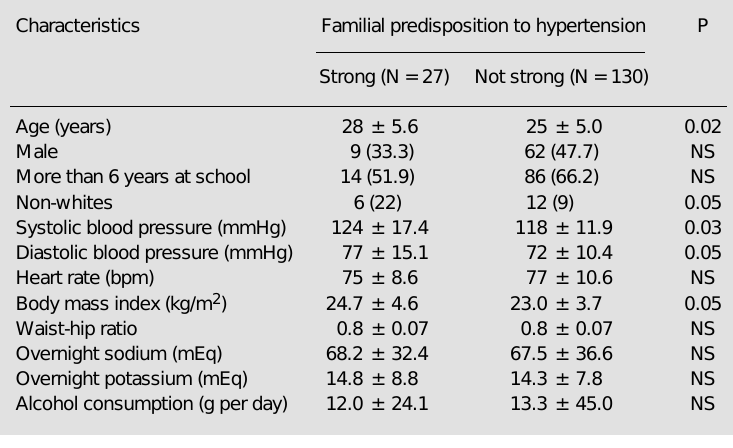
Table 2 - Pearson correlation coefficient between overnight urinary sodium excretion and systolic and diastolic blood pressure in individuals classified by familial predisposi- tion to